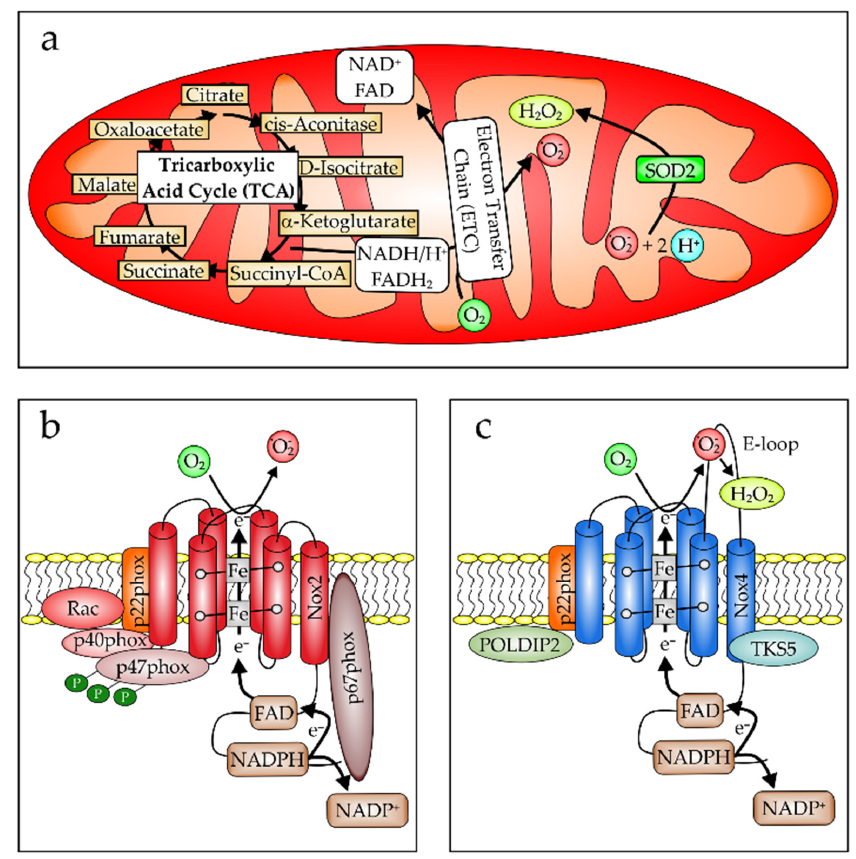
Figure 1. Intracellular ROS production. ( a ) Mitochondria are an important source of intracellular ROS production (mod. from [125]). Being responsible for cellular ATP generation, mitochondria contain the electron transport chain (ETC), and when uncoupled or damaged, ROS can be formed accidentally. The ETC is located in the inner mitochondrial membrane. However, complexes I and III of the respiratory chain also mainly produce O 2 − in intact mitochondria [126], contributing to the cellular redox load [127]. ( b ) Phagocytes such as neutrophils and monocytes/M Φ express Nox2. This is a component of a multiprotein complex, formed in the cell membrane upon cell activation. Nox2, which is also named gp91phox, the subunits p40phox, p47phox, p22phox, and p67phox are required to transfer an electron from NADPH to FAD and then via the Fe of the two associated heme groups to O 2 , leading to generation of the superoxide radical O 2 − . ( c ) In contrast, Nox4 is expressed